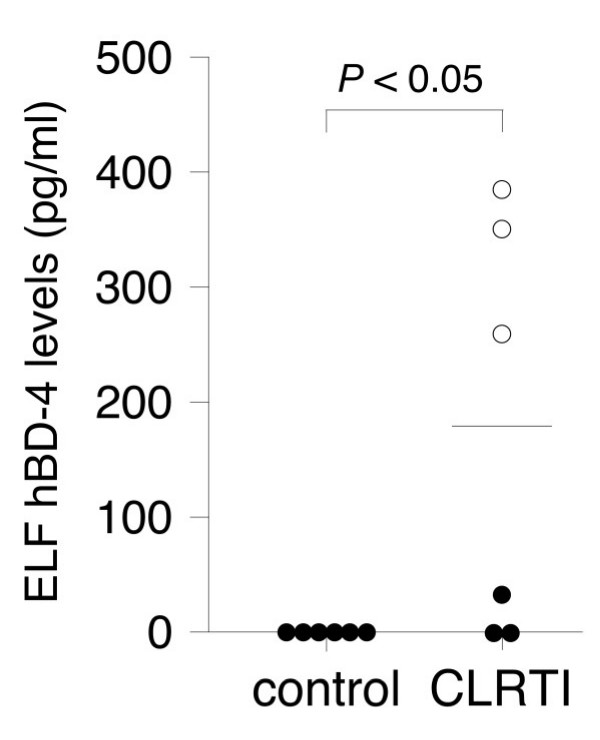
Epithelial lining fluid levels of hBD-4 in controls (n = 6) and patients with chronic lower respiratory tract infection (n = 6). In the CLRTI group, open circles indicate patients infected with the mucoid phenotype of P. aeruginosa, and closed circles indicate patients infected with the nonmucoid phenotype of P. aeruginosa. The horizontal bar represents the mean value. (CLRTI: chronic lower respiratory tract infection, ELF: epithelial lining fluid)